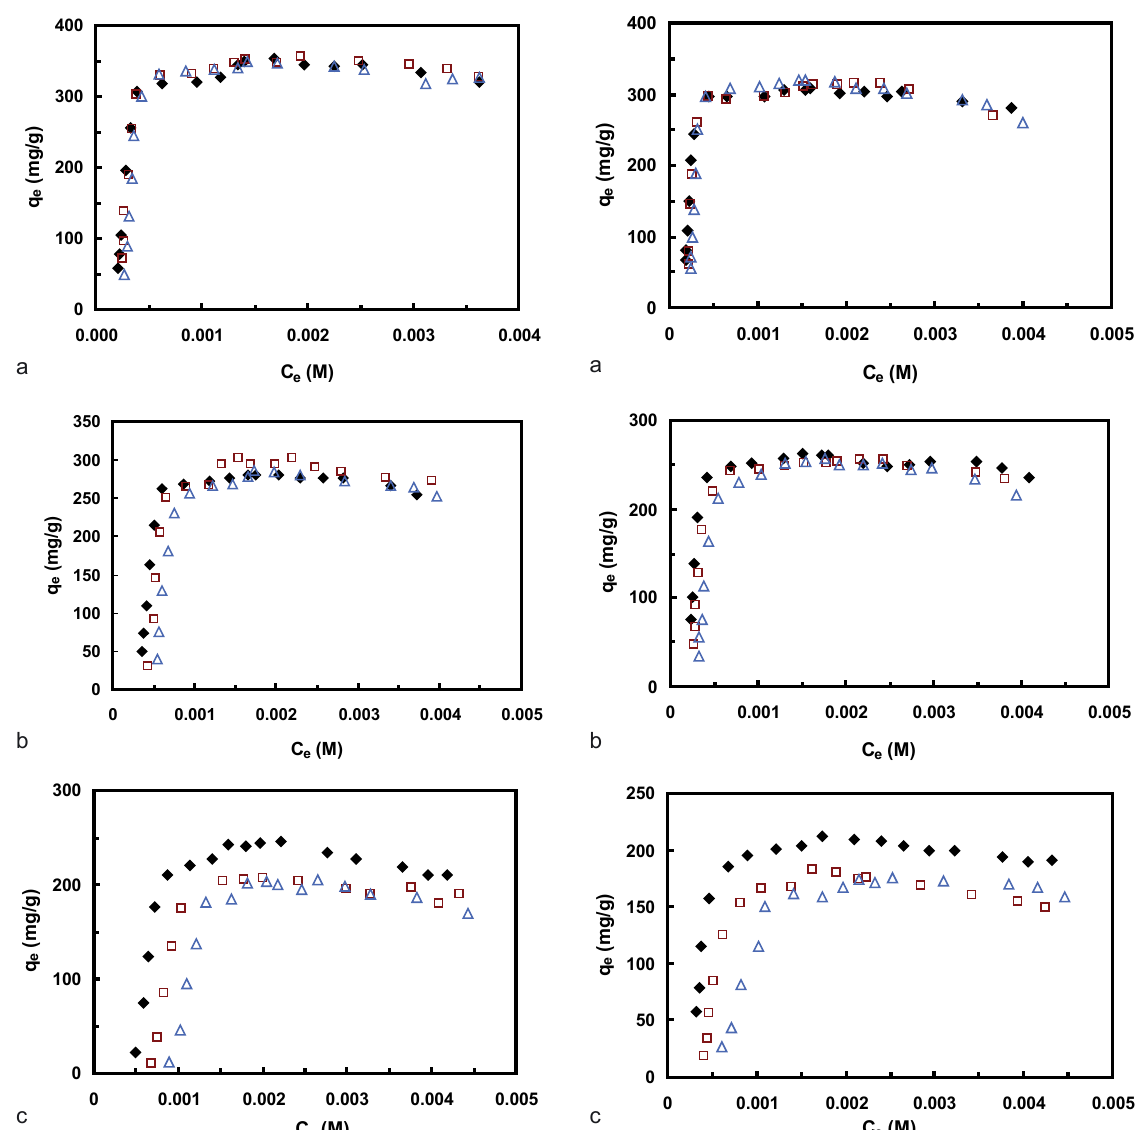
Figure 3. Adsorption isotherms of TX-100 on silica gel from (a) 5%, (b) 10% and (c) 14% ethanol-water solutions at ♦ 308, □ 318 and ∆ 328 K.